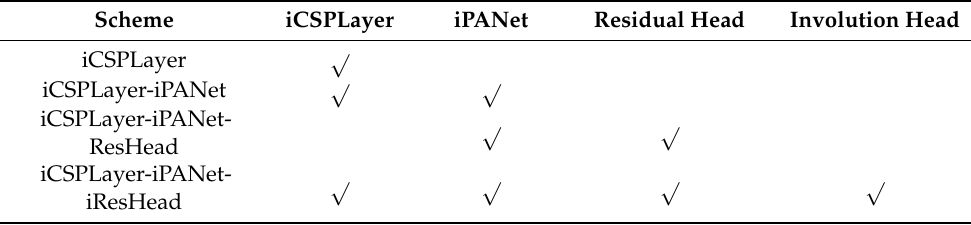
Table 2. Different schemes based on